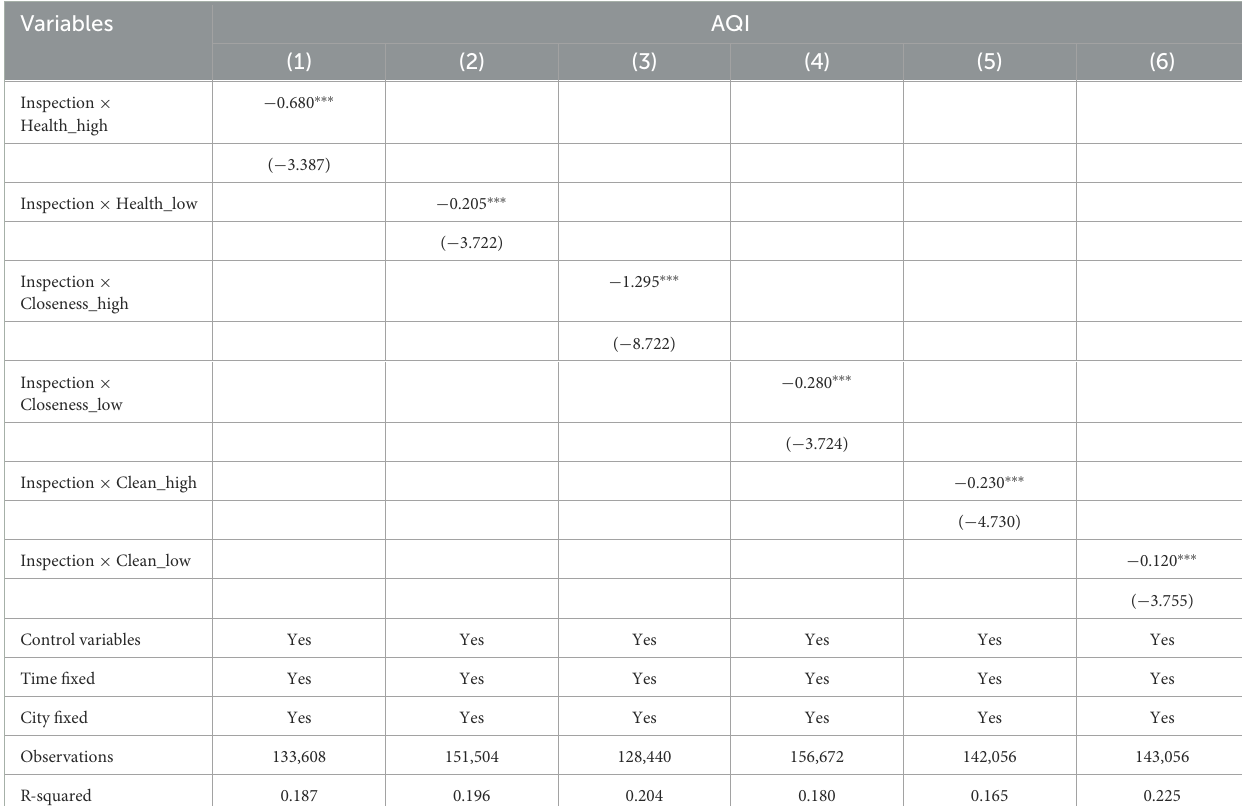
TABLE 9 Regression results of the moderating mechanism test based on the government-business relations.